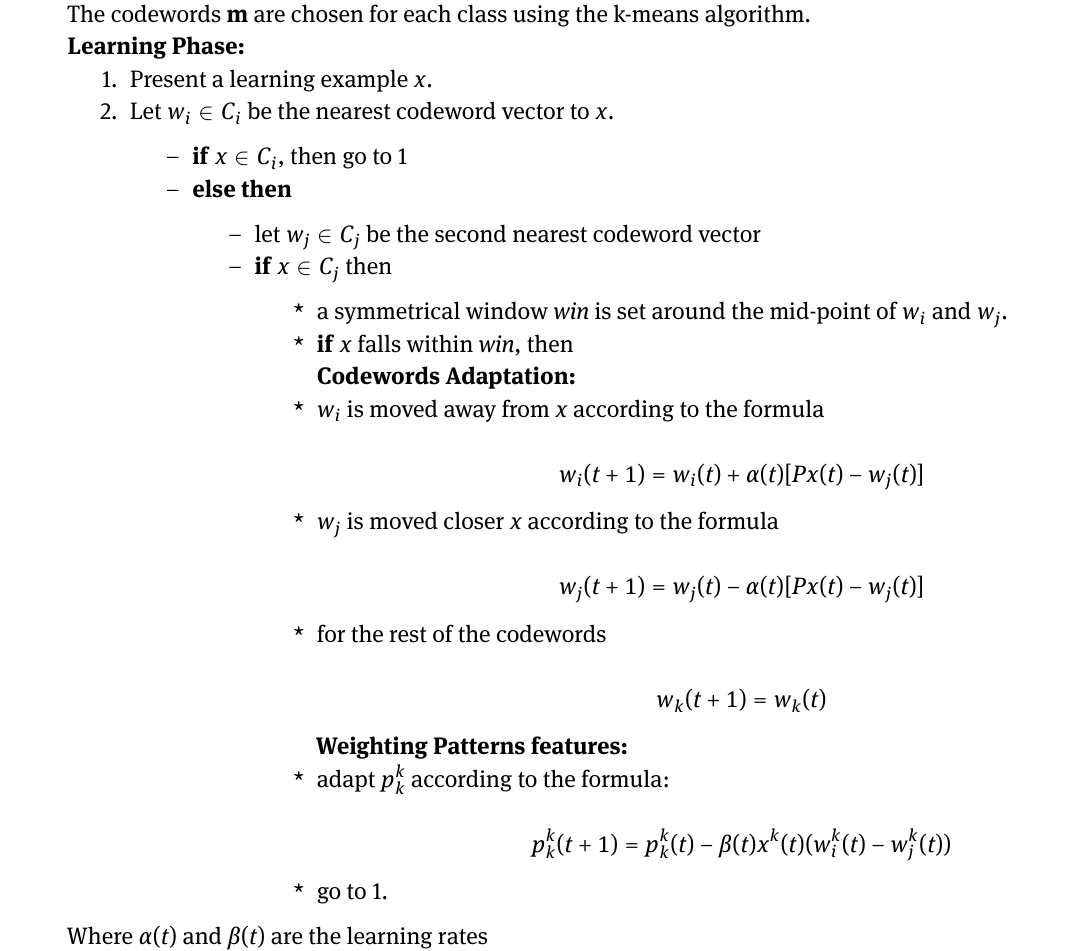
Algorithm 4: Adaptive Weighting of Pattern Features During